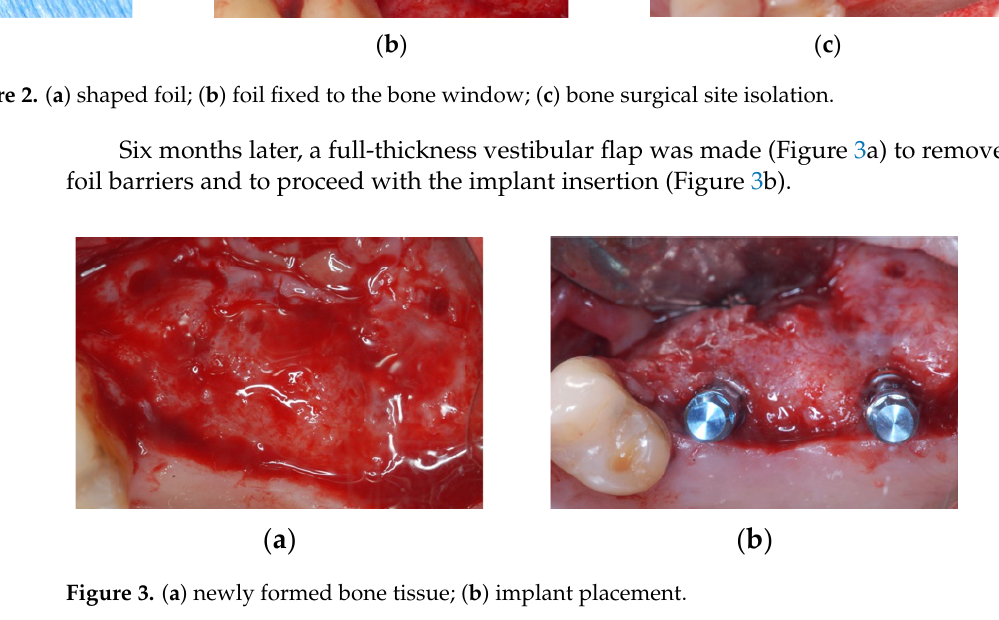
Figure 3. ( a ) newly formed bone tissue; ( b ) implant placement. The pre-implant CT showed (Figure 4) the new bone volume obtained with the Figure 4. Foil radiographic checks: in evidence the shape of the foil. Figure 4. Foil radiographic checks: in evidence the shape of the procedure, which was sufficient to allow the implant insertion. The histological examination of the regenerated bone evidenced the presence of newly generated bone tissue (Figure 5).